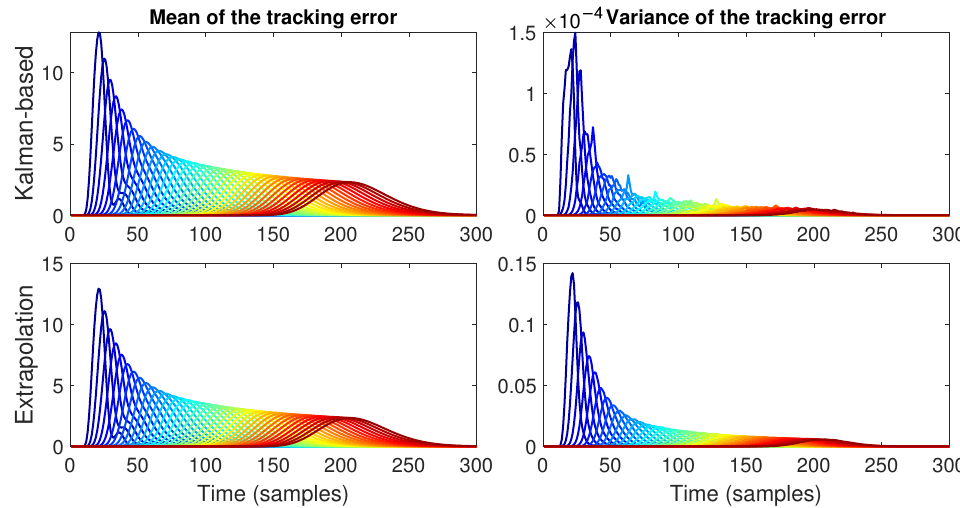
( k ) and variance σ 2 ( k ) of the tracking error for p = 0.95. The variance of the Figure 13. Mean µ ζ ζ i i Kalman strategy has a peak value of 1.5 × 10 − 4 , whereas the peak value for the extrapolation strategy variance is close to 0.15.